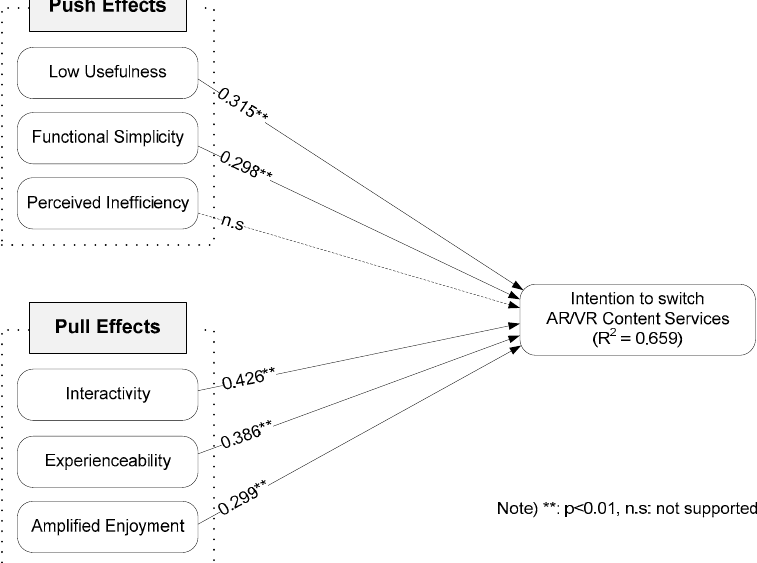
ff ects—H1 to H6).